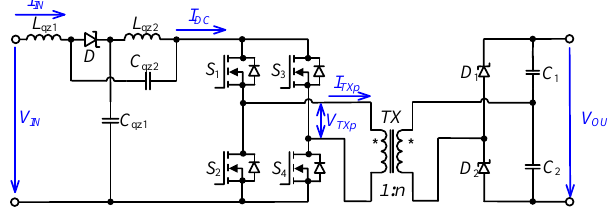
Fig. 1. Galvanically isolated qZS full-bridge DC-DC